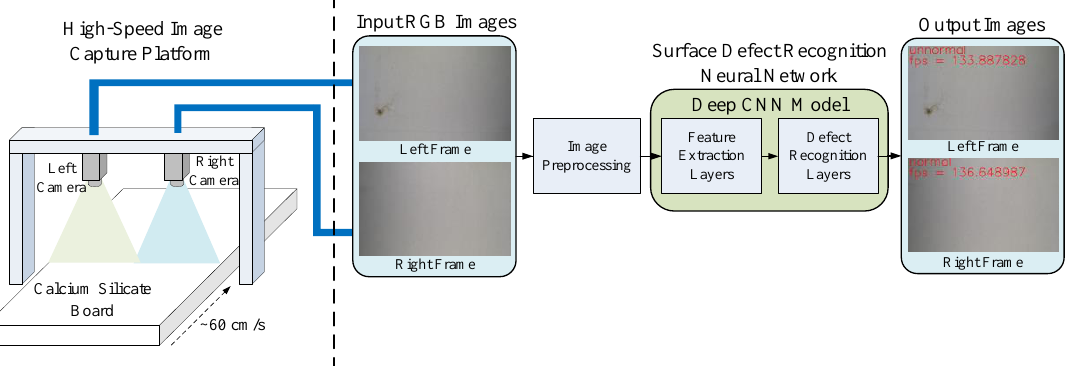
Figure 2. System architecture of the proposed surface defect recognition system.